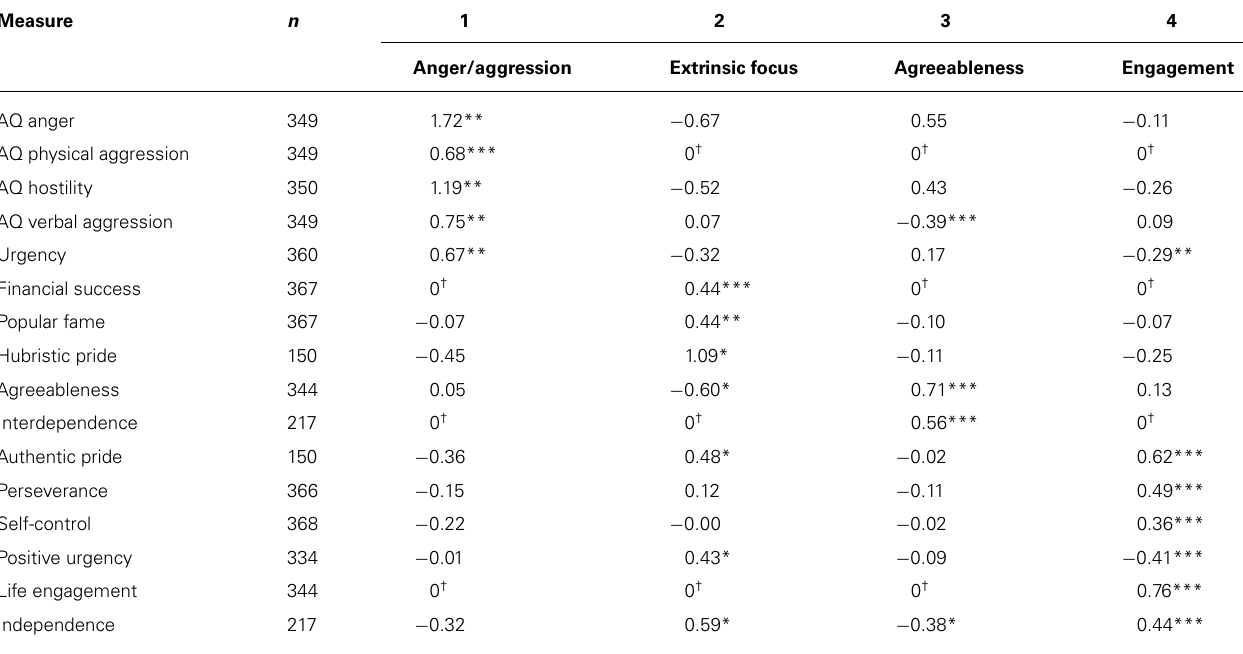
Table 2 | Standardized loadings for personality scales, from exploratory factor analysis within confirmatory framework, using full information maximum likelihood estimation. Measure n 1 2